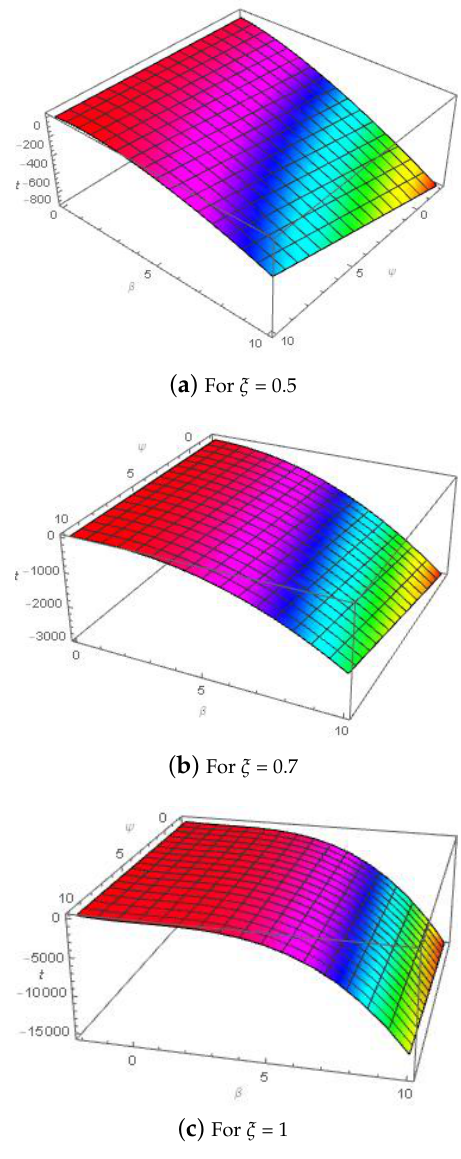
Figure 2. Representation of ψ for different values of ξ